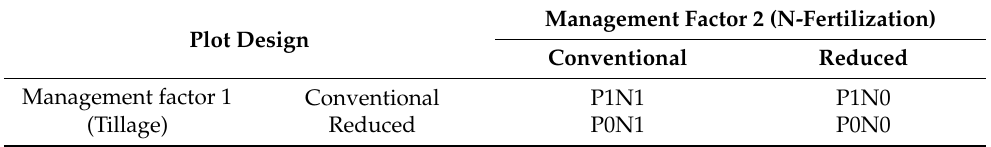
Table 3. Field experimental design of tillage and N-fertilizer applications. Plot